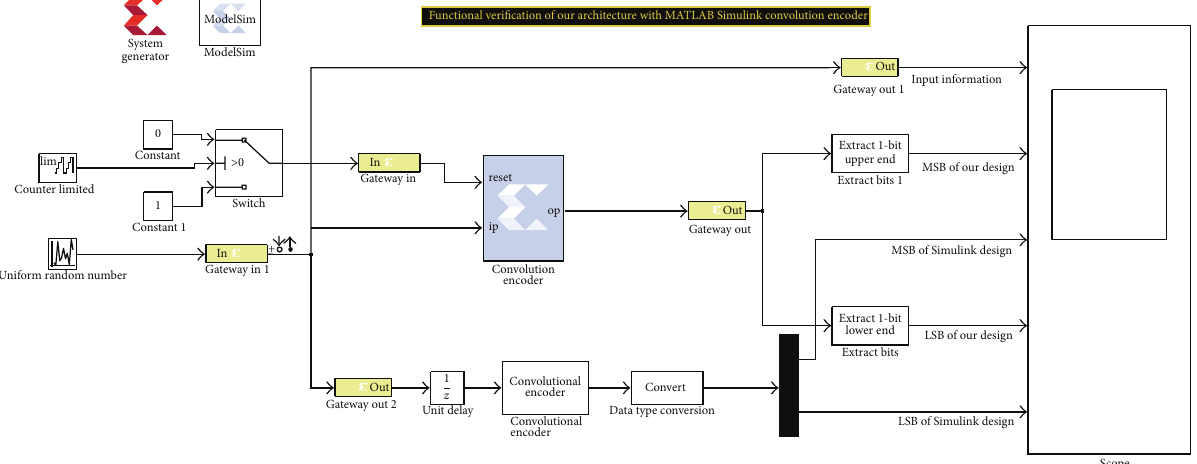
Figure 4: XOR-FREE architecture for GSM-900 standard with generator polynomials 𝑔 0 (𝑥) = (31) 8 and 𝑔 1 (𝑥) = (33) 8 .